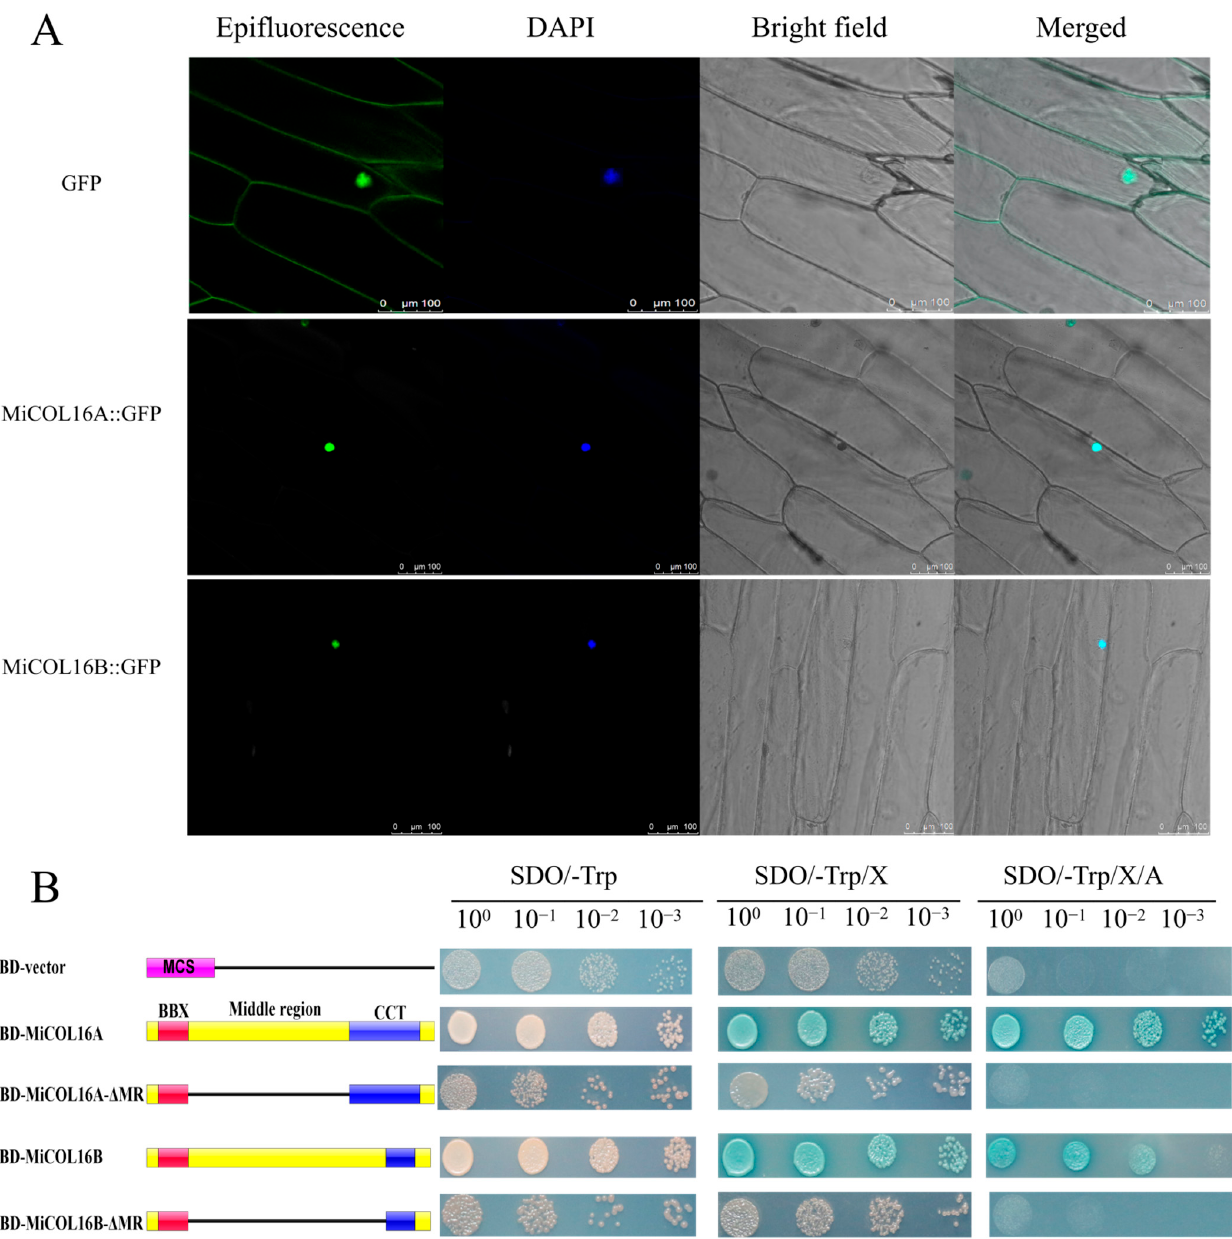
Figure 4. ( A ) Subcellular localization. Scale bars = 100 µm. ( B ) Transcriptional activation